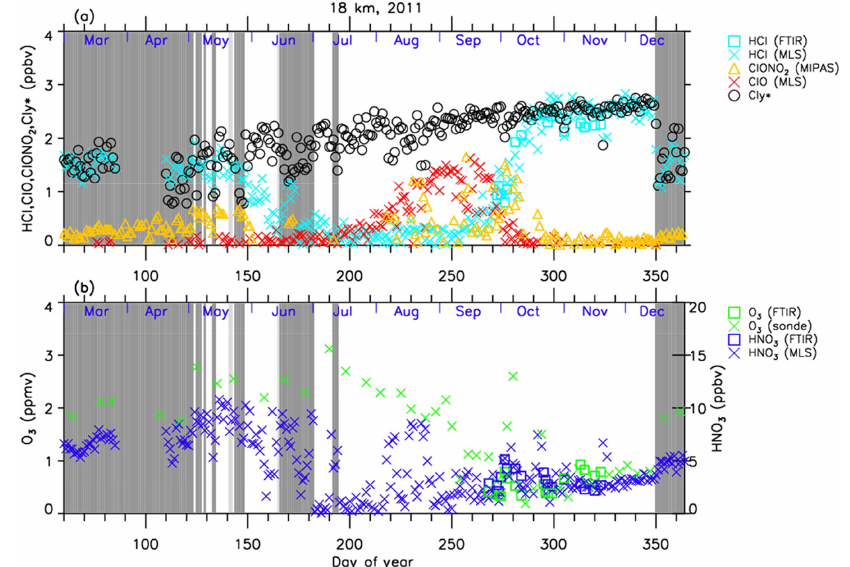
Figure 5. Same as Fig. 4 but in